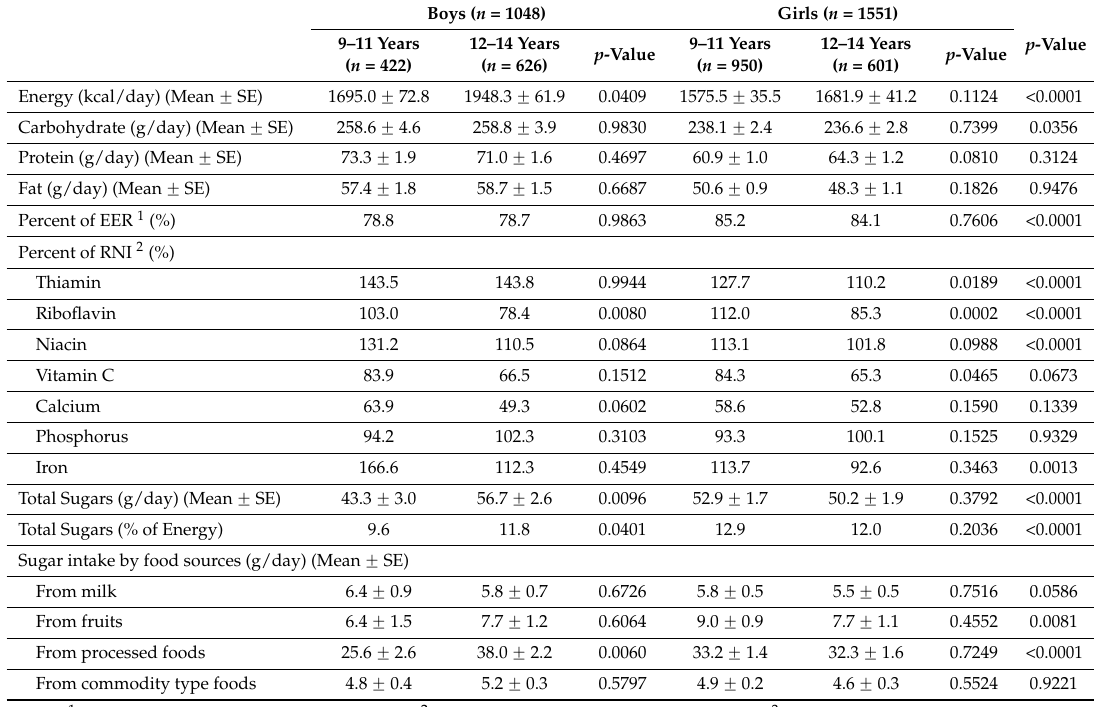
Table 2. Mean daily nutrient intake and sugar intake from food sources according to gender and age